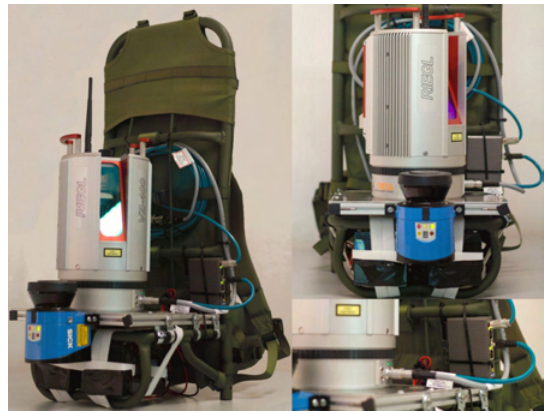
Figure 6: Images of the backpack system. Left: Side view with all of its sensors and equipment. Right: Detailed view of the SICK and the switch.